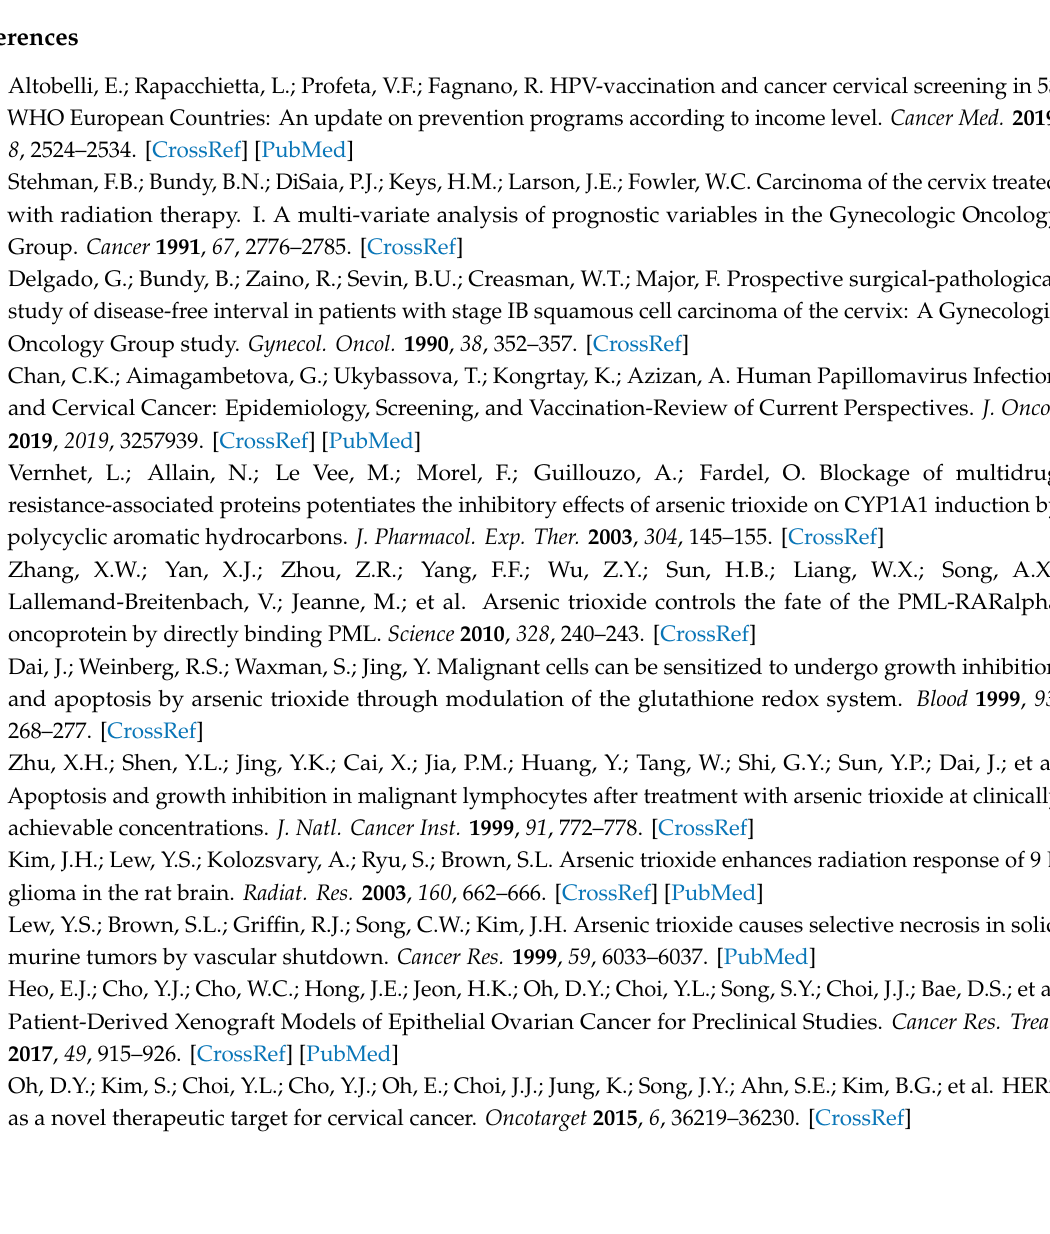
Figure S1: T2 sagittal magnetic resonance imaging (MRI) of the cancer lesion that was used to generate the patient-derived xenograft (PDX) I. Figure S2: T2 sagittal MRI of the cancer lesion that was used to generate the PDX II. Figure S3: T2 sagittal MRI of the cancer lesion that was used to generate the PDX III. Figure S4: T2 transverse MRI of the cancer lesion that was used to generate the PDX IV (top). Figure S5: T2 transverse MRI of the cancer lesion that was used to generate the PDX V (top). Table S1: Clinical information of the patients for patient-derived xenograft